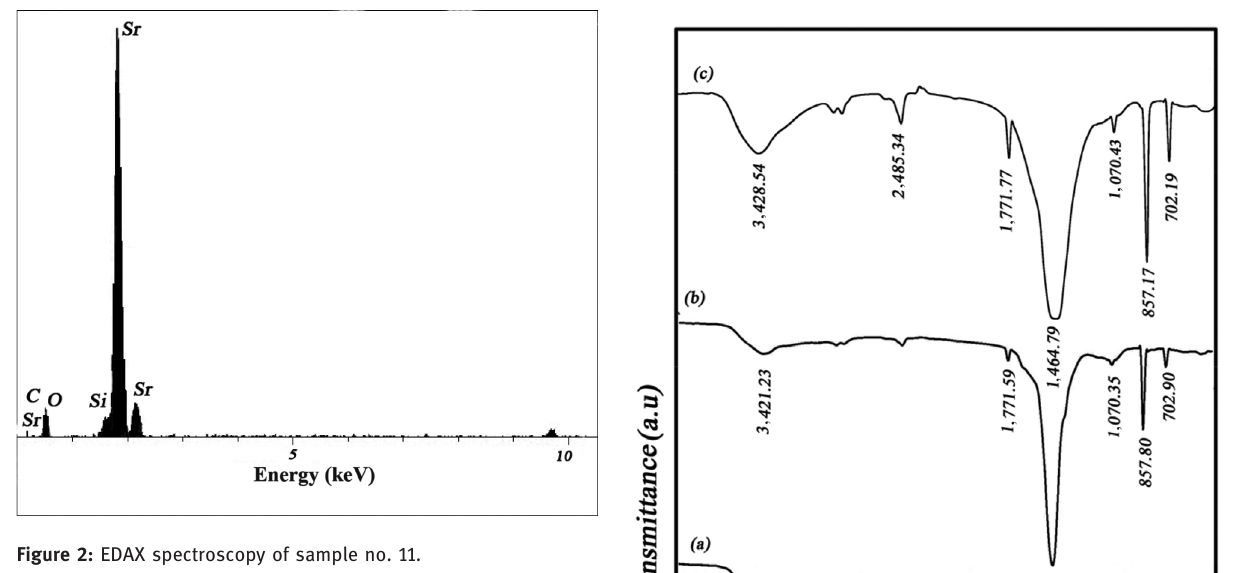
Figure 2: EDAX spectroscopy of sample no. 11.